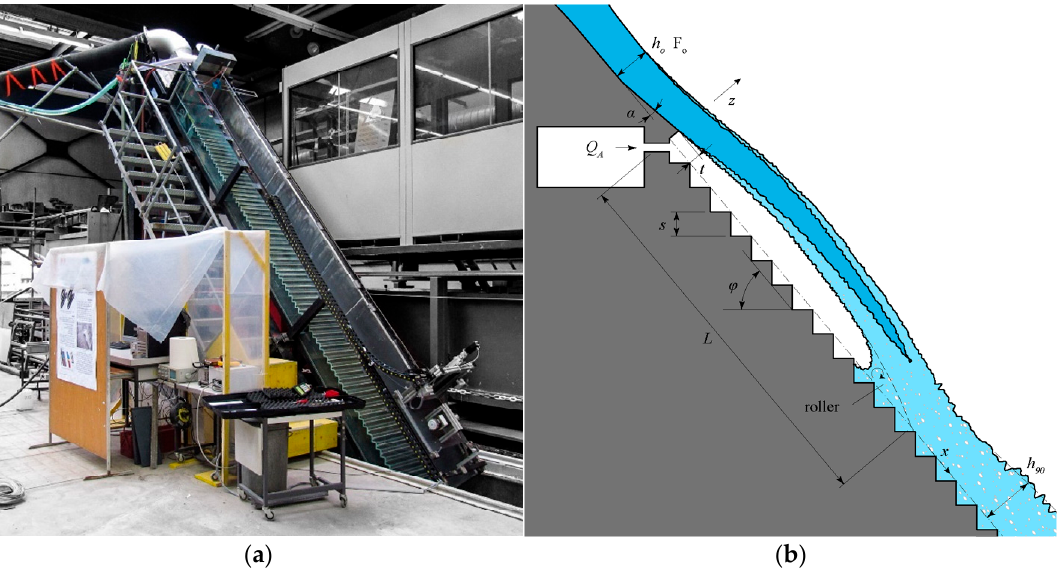
Figure 1. ( a ) Experimental facility with a chute bottom angle of φ = 50°; ( b ) Definition scheme of a stepped spillway aerator.